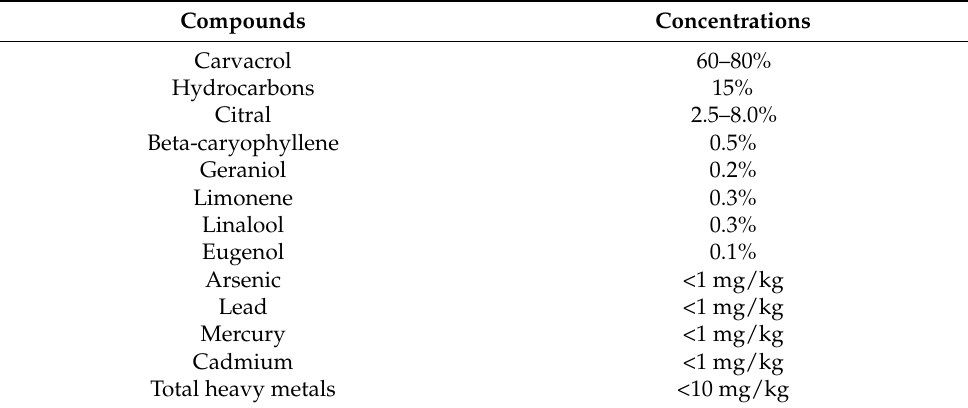
Table 2. Chemical composition of Origanum vulgare L. essential oil 1